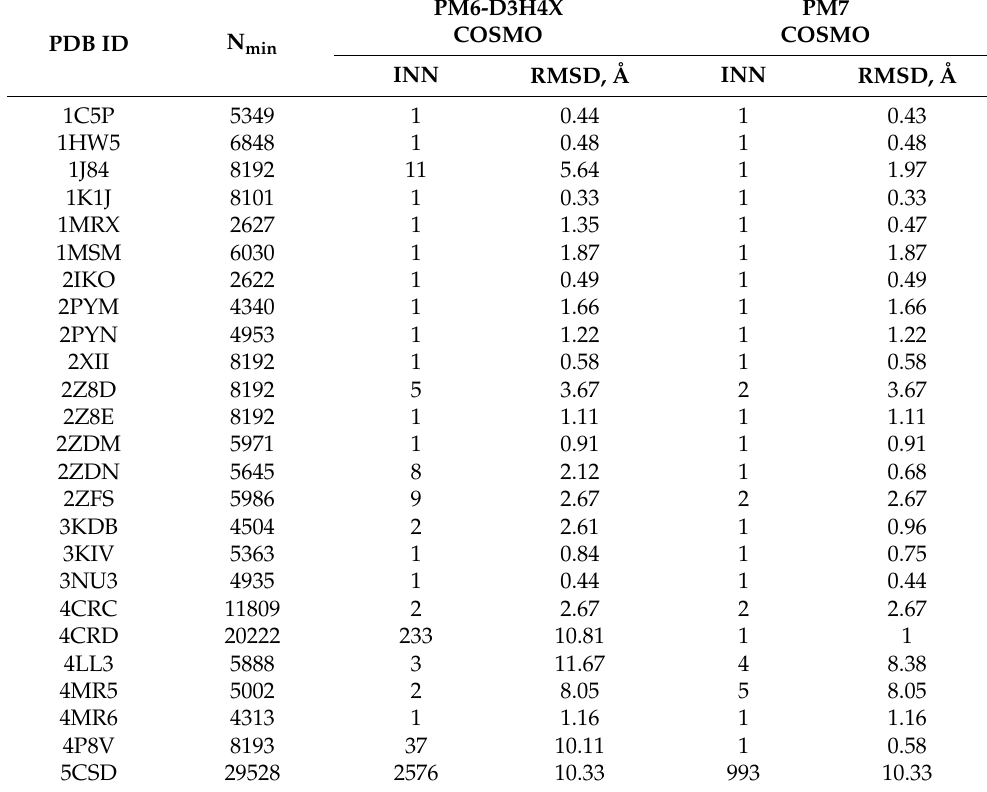
Table 2. The INN indices of minima found by the quasi-docking procedure using either PM6-D3H4X or PM7 with the COSMO solvent at the second step of the procedure. PDB ID is the identifier of the complex in Protein Data Bank, RMSD is the standard deviation between the ligand position corresponding to the global energy minimum and the crystallized ligand position. N min is the number of unique energy minima found by the FLM program at the first step of the quasi-docking procedure.